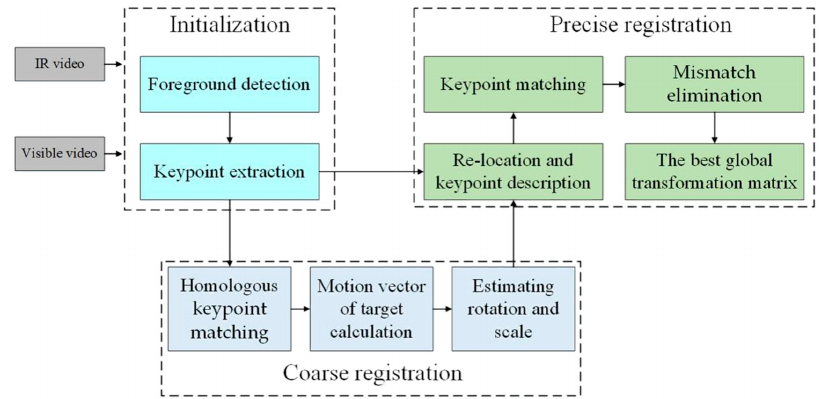
Figure 1. The flowchart of the proposed framework.